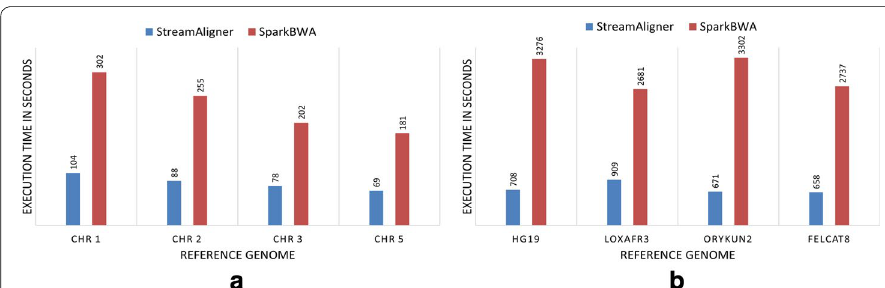
Fig. 9 Index generation time for StreamAligner and SparkBWA. a Performance for different chromosomes. b Performance for different